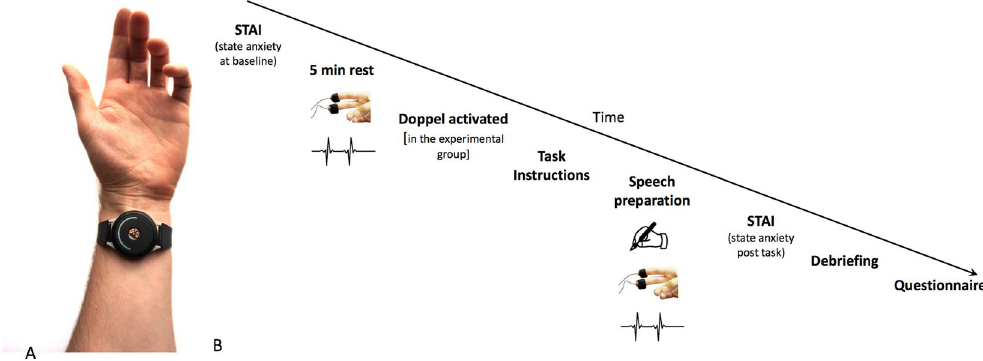
Figure 1. The doppel device ( A ) and the timeline of the experimental procedure ( B